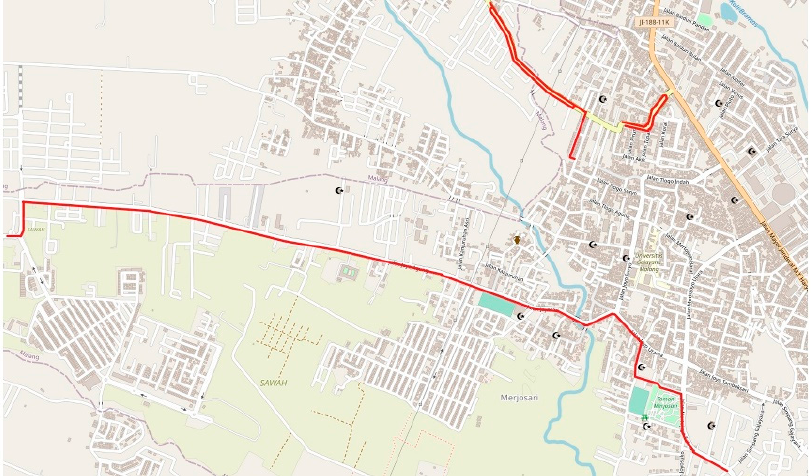
Figure 6. Data acquisition routes (marked with red) in Malang, Indonesia. (Map data copyright by OpenStreetMap contributors; available from https://www.openstreetmap.org/#map=16/-7.9383/11 2.5941, accessed on 14 March